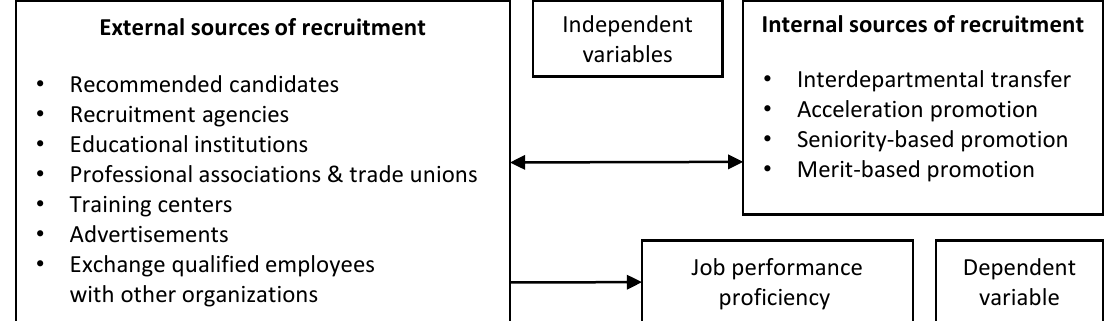
External sources of